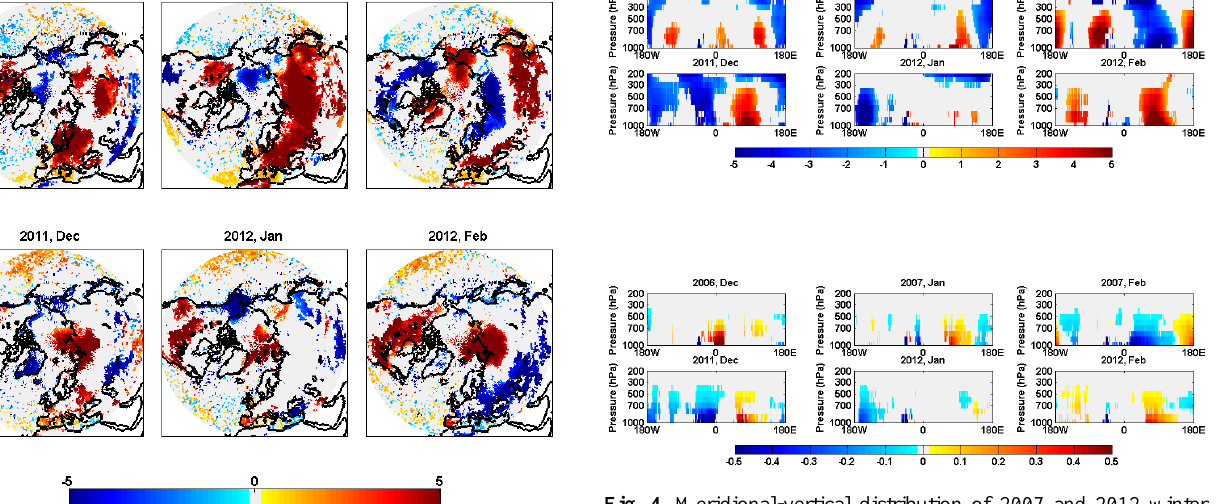
Fig. 4. Meridional-vertical distribution of 2007 and 2012 winter Fig. 4: Meridional-vertical distribution of 2007 and 2012 winter (DJF) temperature anomalies [K] (top two rows) and water vapour mass mixing ratio anomalies [g/kg] (DJF) temperature anomalies [K] (top two rows) and water vapour (bottom two rows). Temperatures and water vapour mixing ratios at each pressure level mass mixing ratio anomalies [gkg − 1 ] (bottom two rows). Temper- are averaged over the latitude band of 65N-75N. The anomalies that lie below one-sigma atures and water vapour mixing ratios at each pressure level are av- level are masked out. eraged over the latitude band of 65–75 ◦ N. The anomalies that lie below the one-sigma level are masked